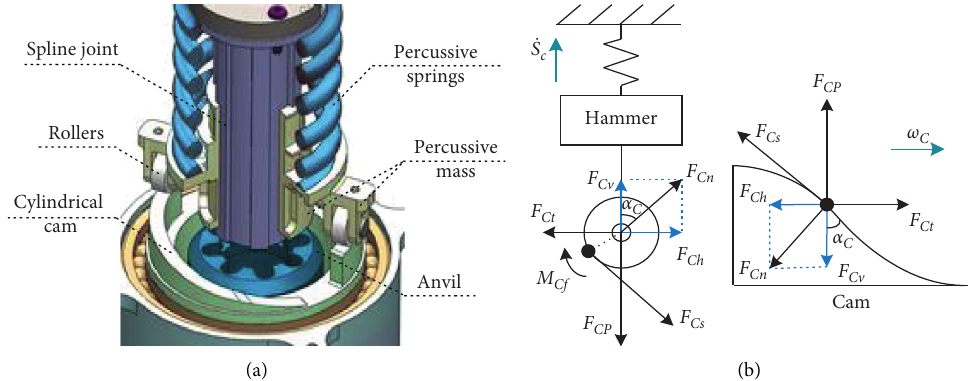
Figure 2: (a) 3D configuration of the percussive mechanism. (b) Force analysis model.